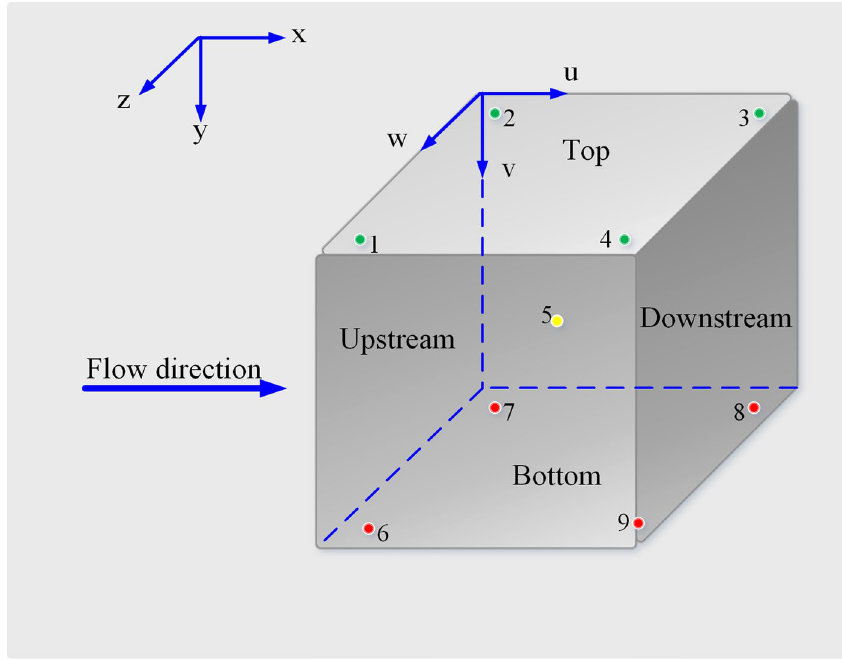
Fig. 1 Schematic of the studied range of the